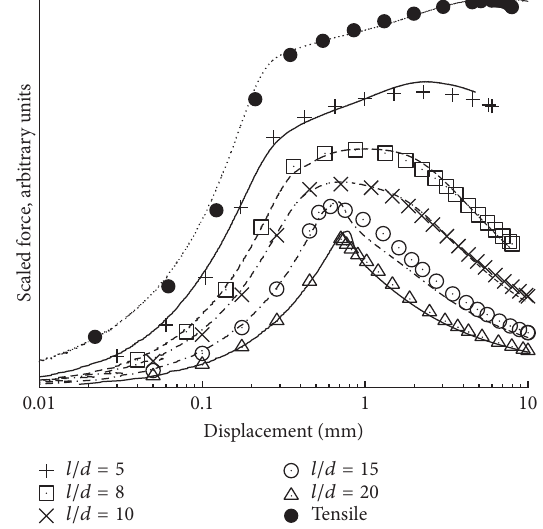
Figure 10: FE load-displacement traces obtained with the best buckling and tensile estimates of the global optimum, 𝜎 0 = 434.2 MPa, 𝑘 = 394.9 MPa, 𝑛 = 0.2021 , and 𝑓( x ∗ ) = 2.355 (see Table 3), are shown as symbols. Superimposed lines show the experimental data. Note that the curves are deliberately separated for clarity, via arbitrary scaling of the load for each dataset. The plot is used exclusively to highlight a match between the FE and the experiment for each